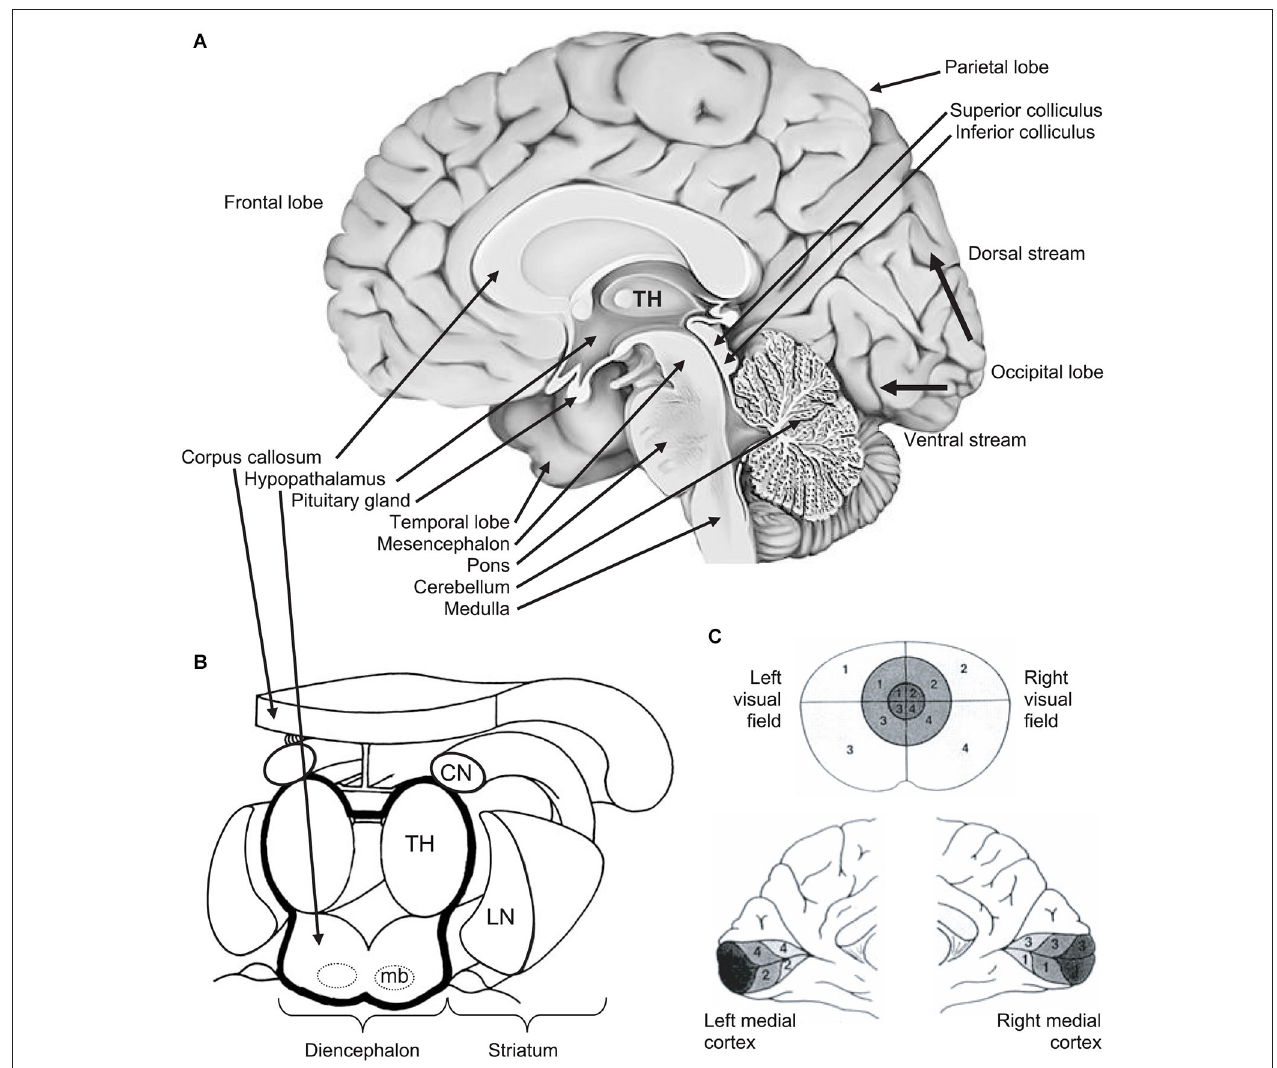
diencephalon. (C) Retinotopy of the retino-occipital visual pathway: organization of projections of the visual field (upper part) in the occipital cortex where the primary visual cortex (or V1) is spread around the calcarine sulcus (medial views in the lower part). Information from central visual field (foveal vision—the darkest in the figure) is projected and over-represented in the posterior part of occipital cortex. Other notations: mb: mammillary bodies; TH: thalamus. From O.A. Coubard (© O.A. Coubard, with